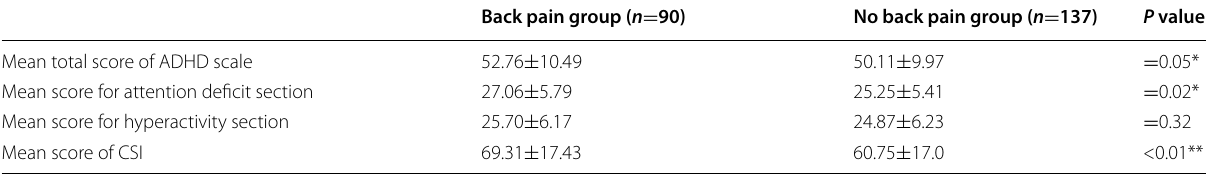
Table 2 Mean scores of attention deficit hyperactivity disorder (ADHD) and central sensitization (CS) among students with and without chronic back